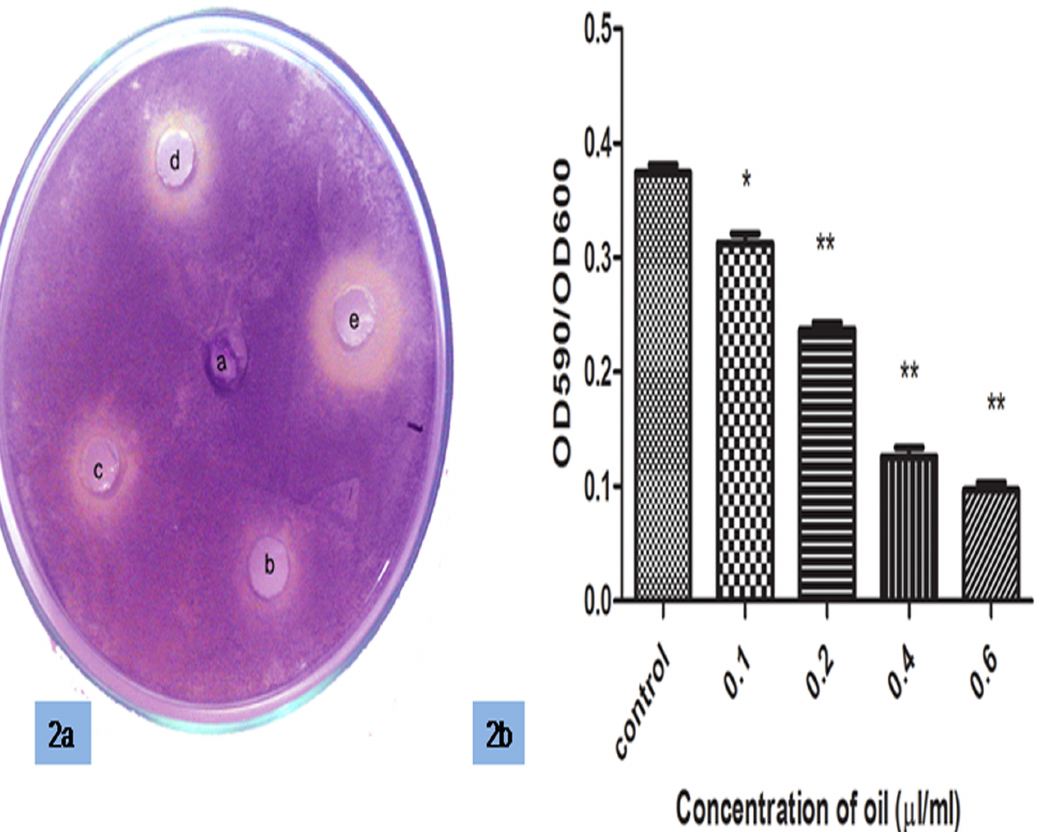
Fig 2. QS inhibition of C . violaceum CV026 by cinnamon oil. (a) The zone of inhibition with increasing concentrations of oil (a-control, b-0.1, c-0.2, d-0.4, e-0.6 μ l/ml). (b) A decrease in violacein production was observed. The color change was measured at 590 nm. The error bars indicate the standard deviations of three measurements, and the data were normalized according to the OD 600 of CV026. * , P < 0.05 compared with the control. ** , P < 0.001 compared with the